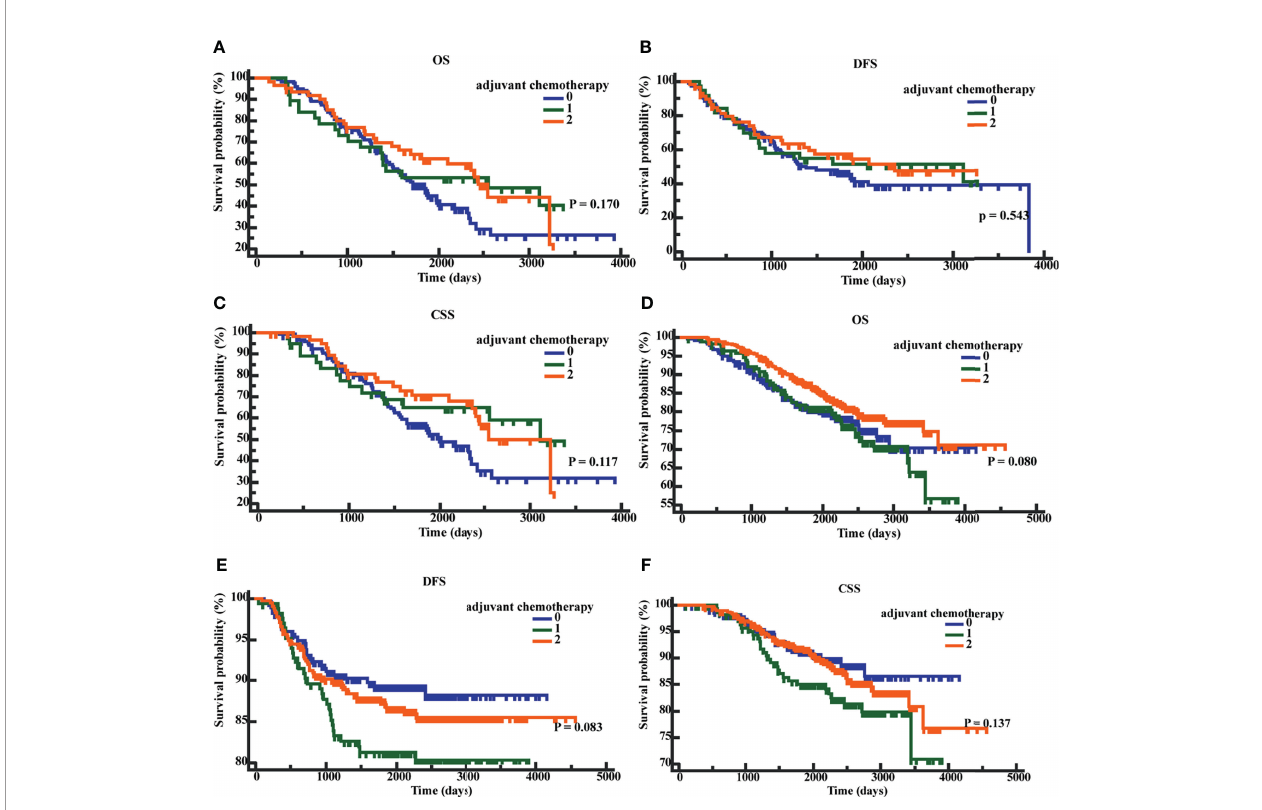
FIGURE 7 | Patients ’ overall survival (OS), disease-free survival time (DFS), and cancer-speci fi c survival (CSS) based on different chemotherapy regimens. (A) K-M curves of OS based on different chemotherapy regimens in postoperative CEA-positive patients. (B) K-M curves of DFS based on different chemotherapy regimens in postoperative CEA-positive patients. (C) K-M curves of CSS based on different chemotherapy regimens in postoperative CEA-positive patients. (D) K-M curves of OS based on different chemotherapy regimens in postoperative CEA-negative patients. (E) K-M curves of DFS based on different chemotherapy regimens in postoperative CEA -negative patients. (F) K-M curves of CSS based on different chemotherapy regimens in postoperative CEA -negative patients. 0, without adjuvant chemotherapy; 1, with 3-month adjuvant chemotherapy; 2, with 6-month adjuvant